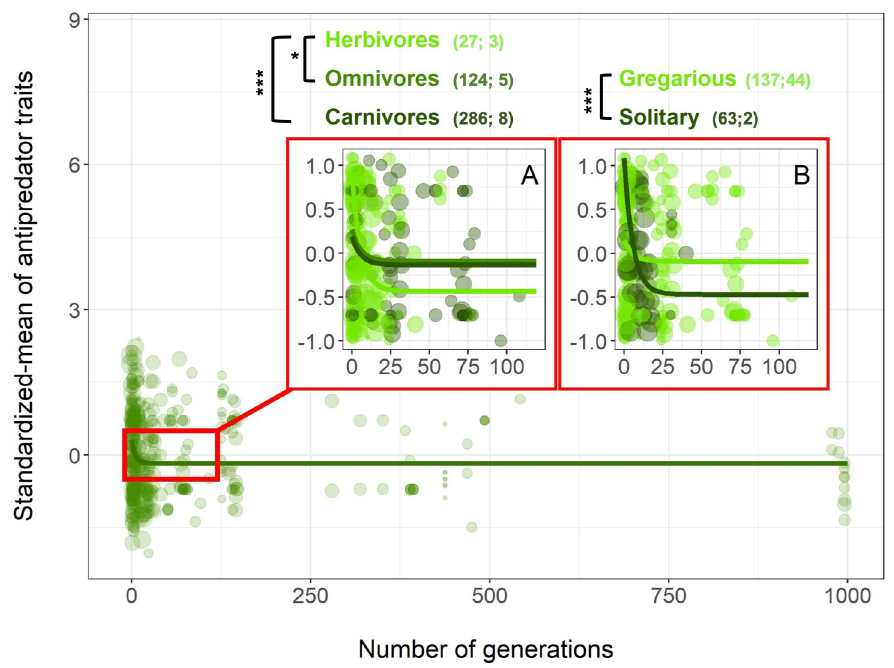
Fig 3. The decrease in average antipredator traits over generations of domestication differs as a function of animal’s foraging type (A) and social status (B). The lines represent the best inverse model with the outputs (slopes and intercepts) of the MCMCglmm. In (A), model was fitted with foraging type × generation interaction. In (B), model was fitted with social status × generation interaction. Dot size is proportional to the log-transformed number of replicates used in each study. The number in brackets represents the number of estimates followed by the number of species. “ � ” indicates significant p -value < 0.05 and “ ��� ” significant p -value < 0.001 between slopes within each life- history trait using the MCMCglmm model (S3 Table). All data and R code supporting the figure are available in S1C Data. MCMCglmm, Markov chain Monte Carlo generalized linear mixed model.